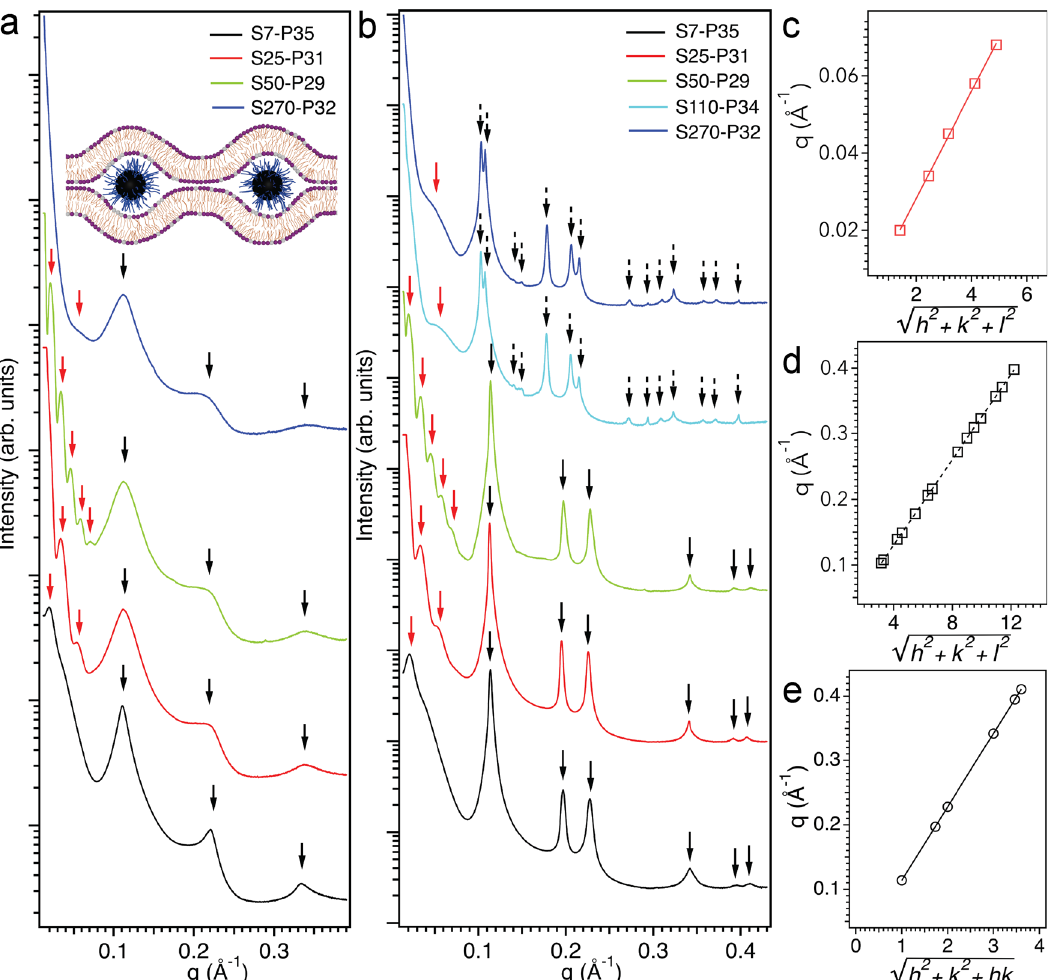
Fig. 4 Synchrotron SAXS reveals that hydrophilic NPPBs remodel biomembranes with different modes of actions depending on both the membrane lipid intrinsic curvature and nanoparticle size. a Mammalian cell-mimicking membrane comprised predominantly of lipids with zero intrinsic curvature are brought to stack onto each other (lamellar harmonics marked by black arrows) with the help of NPPBs adhered in the membrane “ bubbles ” (inset illustration: NPPBs represented by hairy balls consisting of a silica nanosphere (black) covalently grafted with P4MVP brushes (blue), and membranes represented by a binary mixture of lipids (hydrocarbon tails in golden) with both PC (purple) and PG (gray) headgroups; illustration not drawn to scale). The well-de fi ned NPPBs themselves are ordered in 3D into cubic structures, and the cubic scatterings (marked by red arrows) show up at the same positions for the same NPPBs interacting with either mammalian cell-mimicking ( a ) or bacteria-mimicking membrane ( b ). c An example of the cubic scatterings from 3D ordered S50-P29 (green trace in a , b ) fi t to their Miller indices is shown. b In contrast, bacteria-mimicking membrane comprised predominantly of lipids with negative intrinsic curvature undergoes a topological transition from planar bilayer to either a 2D hexagonal ( d silica ≤ 50 nm) or a 3D cubic membrane structure ( d silica > 50 nm) when encountering NPPBs of different sizes. The characteristic scatterings from the remodeled 2D hexagonal and 3D cubic membrane structures are marked by solid and dashed black arrows ( b ), respectively, and fi t nicely to their Miller indices ( e , d